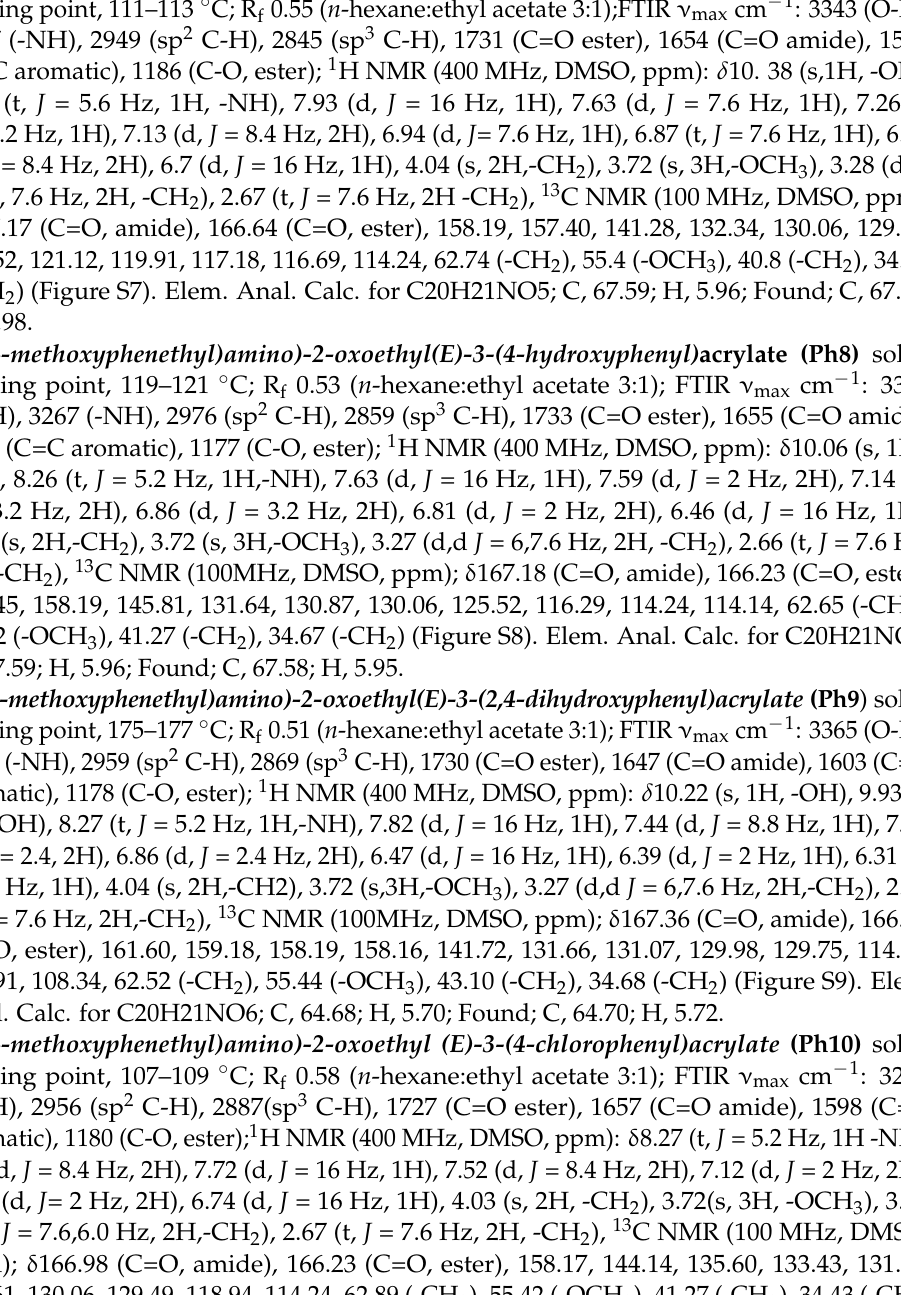
(Figure S10). Elem. Anal. Calc. for C20H20ClNO4; C, 64.26; H, 5.39; Found; C, 64.24; H,